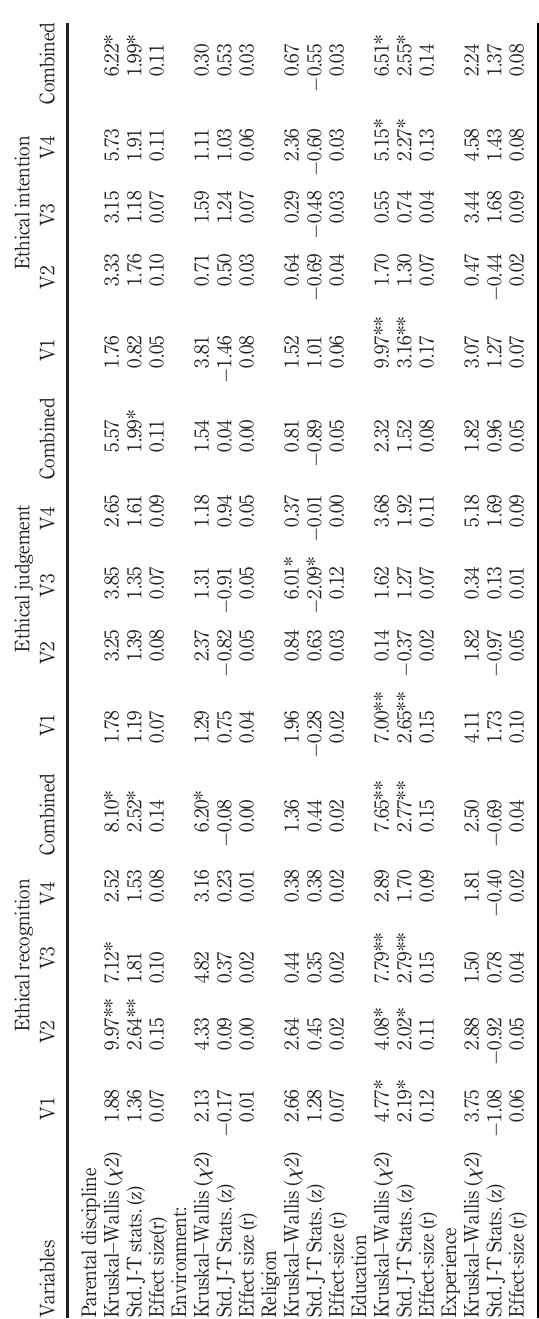
Table 5. Kruskal – Wallis and Jonckheere –